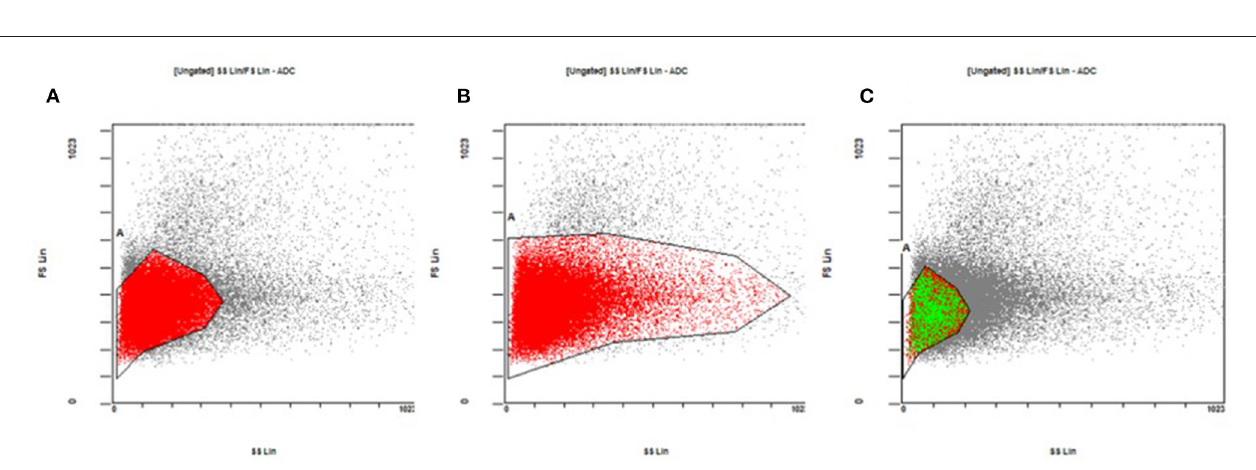
FIGURE 6 | Gating strategies for the sampling of red blood cells on the size vs. complexity dual plot. (A) The core of the cloud of the events. (B) The core of the cloud and its entire tail, enclosing both mature and immature red blood cells. (C) The core of the red blood cell cloud, but limited to the area typical of the donor red blood cells (see the text for more